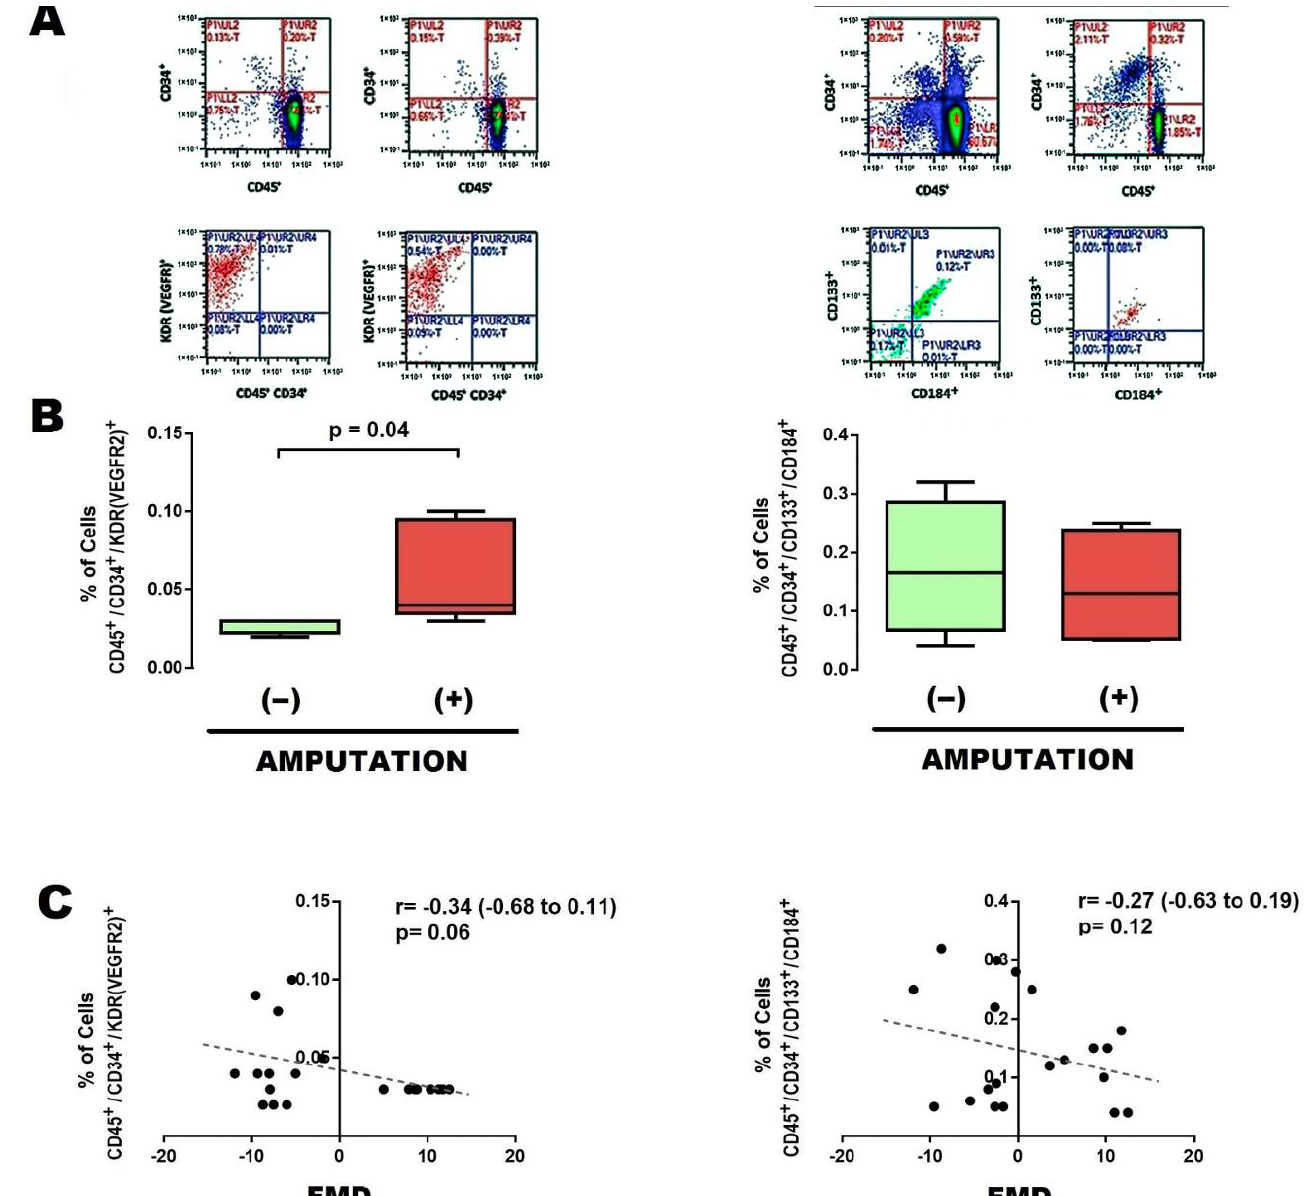
Figure 1. Baseline EPCs in patients with limb amputation. ( A ) Typical results of flow cytometry, with the markers used to identify EPCs in the preangioplasty phase, either in EPCs CD45 + ,CD34 + ,KDR [VEGFR2] + (left panel) or CD45 + ,CD34 + ,CD133 + ,CD184 + (right panel). ( B ) Percentage of populations of EPCs CD45 + ,CD34 + ,KDR [VEGFR2] + (left panel) and CD45 + ,CD34 + ,CD133 + ,CD184 + (right panel), present in blood circulation at a site near the vascular lesion, in cases that evolved without limb amputation ( − ) and with limb amputation (+). ( C ) Correlation between percentage of populations of EPCs vs. flow-mediated dilation (FMD). Comparisons were made with U-Mann–Whitney and Kruskall– Wallis, 1-way. Abbreviations: EPCs, endothelial progenitor cells; FMD, flow–mediated dilation.